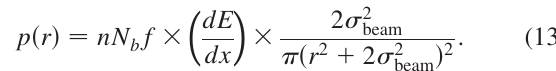
Between two consecutive bunch trains (over a period